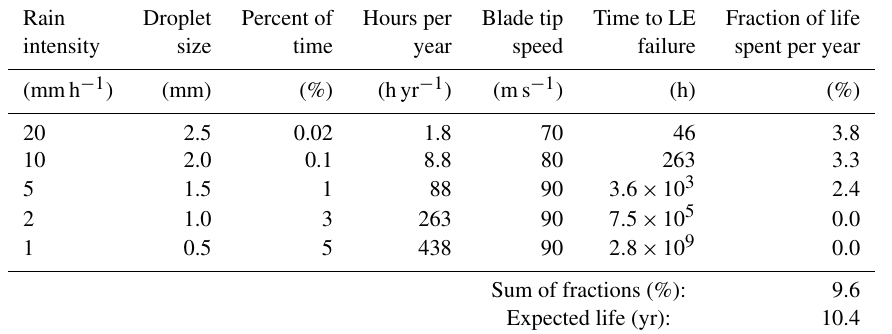
Table 5. Calculation of the expected lifetime of the blade leading edge with a reduction in the tip speed to 70 and 80ms − 1 : Control Strategy 2.